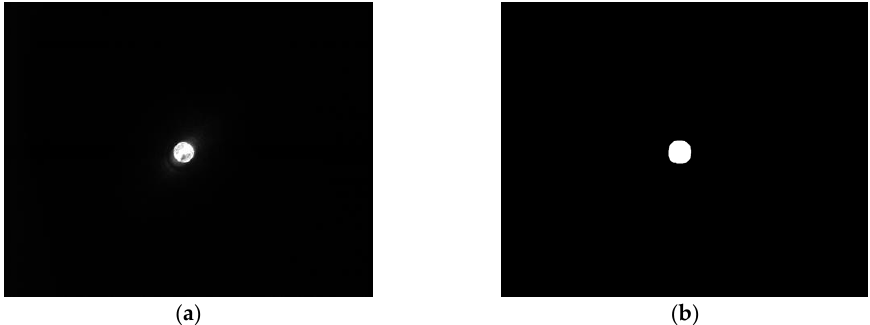
Figure 6. ( a ) Complete frame without image processing; ( b ) Complete frame with image processing to binary